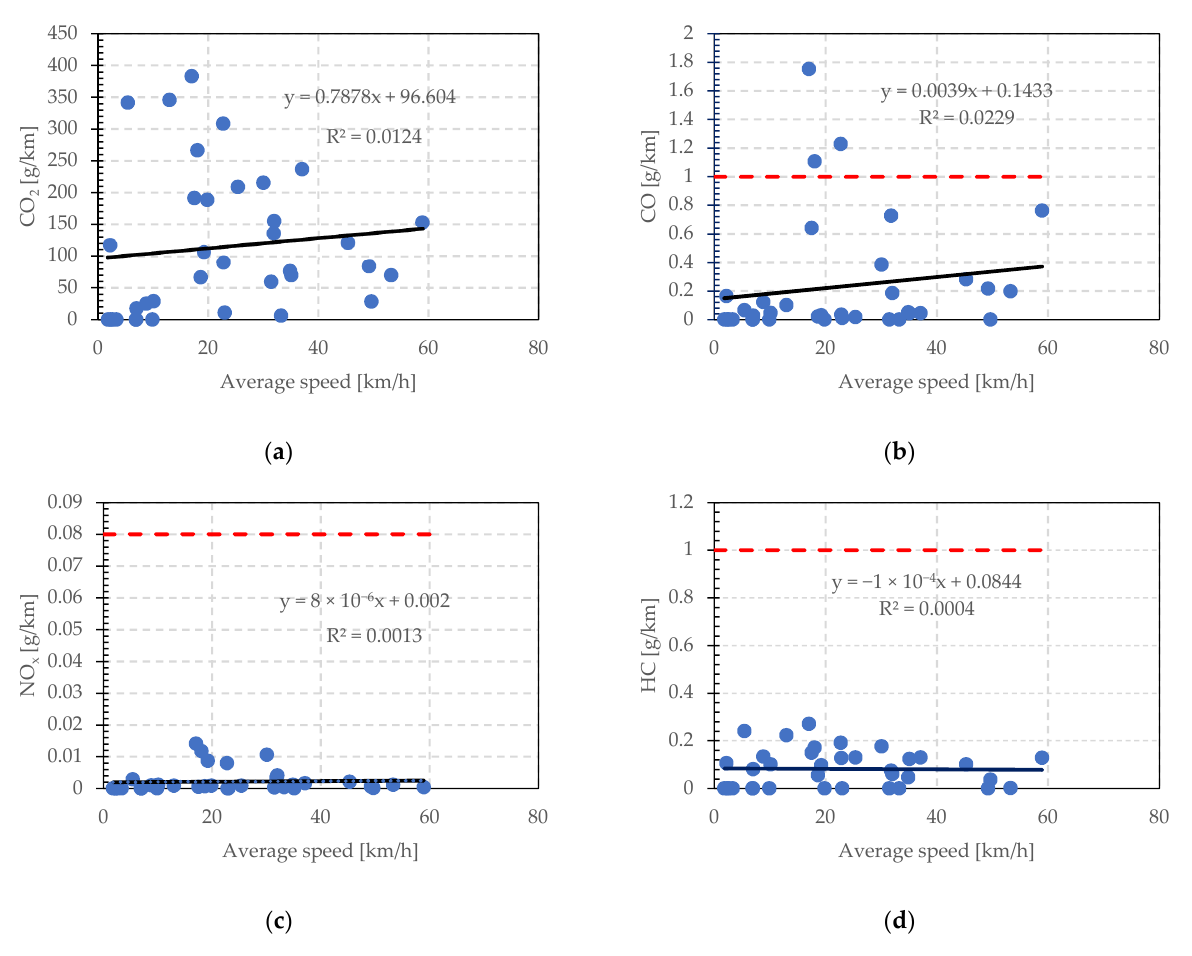
Figure 12. Correlation between the emission factors of ( a ) CO 2 , ( b ) CO, ( c ) NO x , and ( d ) HC and the average speed of micro-trips for HVB1. The dashed line indicates the Euro 4 standard limit.